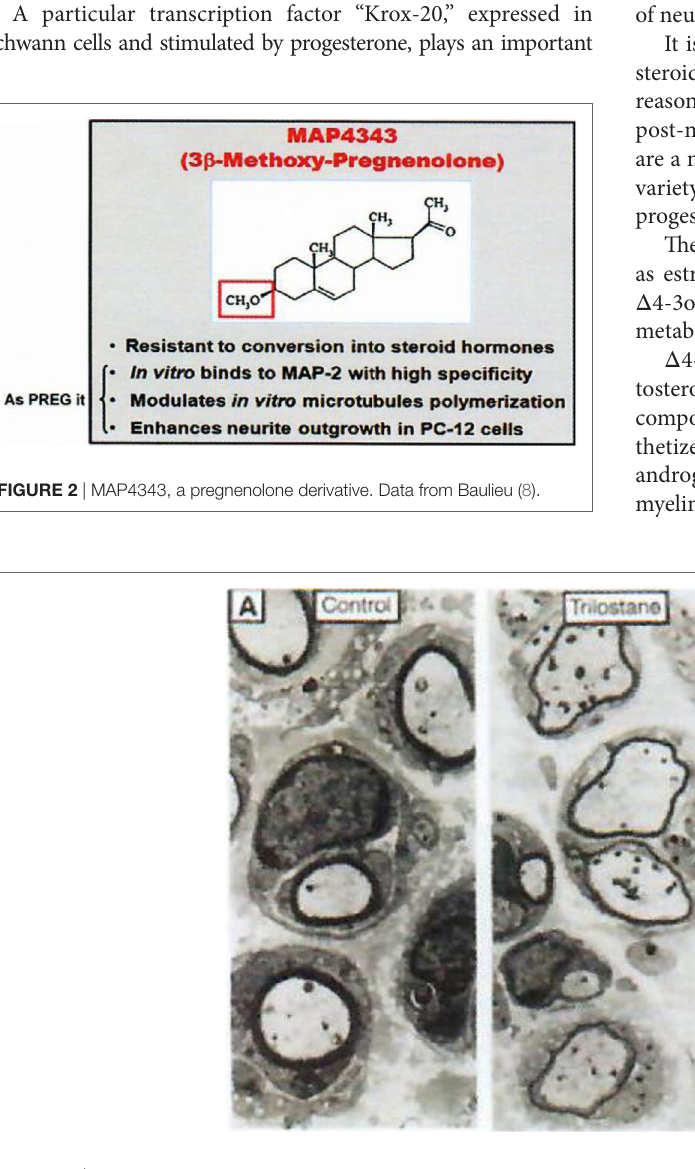
FIGURE 3 | Role of neurosteroids in the formation of myelin sheaths. The thickness of myelin sheaths (number of lamellae) was quantified by electron microscopy of cross section of sciatic nerves from male mice 15 days after cryolesion. Effect of trilostane in the absence (center panel) or presence (right panel) of progesterone on the thickness of myelin sheaths, relative to that in control nerves (left panel). Scale bar, 2 µm. Data from Koenig et al.